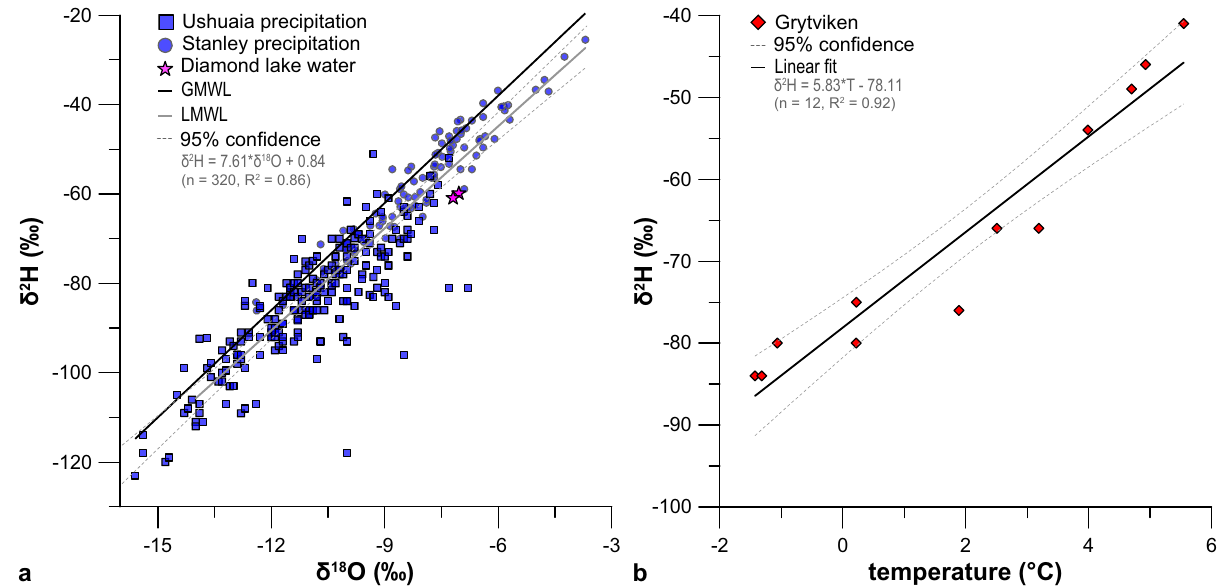
Fig. 2 Isotope characteristics of meteoric and lake water. a Relationships between source water precipitation hydrogen isotope values ( δ 2 H) and oxygen isotopes ( δ 18 O) in samples collected between 1965 – 2016 CE from the most proximal weather stations in Stanley and Ushuaia along the global (GMWL: black) and local (LMWL: gray) waterlines 45 . b Monthly temperatures at the nearby (~10 km away) Grytviken weather station (see Fig. 1a) 23,42 . Regression fi ts with summary statistics between plotted variables are shown in gray. The pinks star ( n = 2) in panel a highlights the isotope value of Lake Diamond water samples taken in February